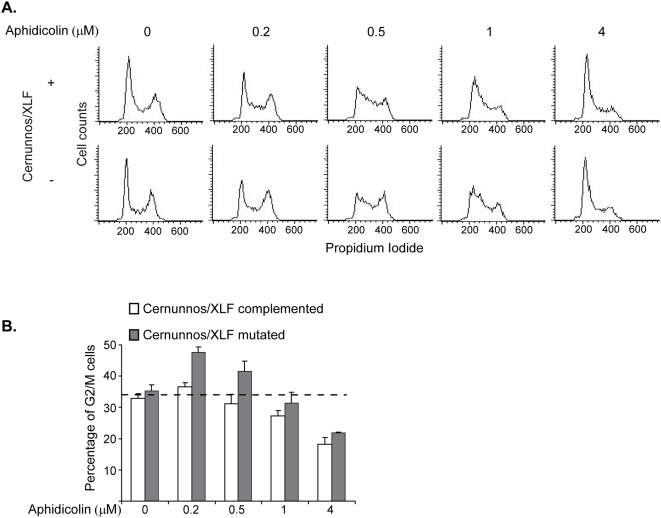
Cernunnos/XLF mutated cells exhibit Increased accumulation of cells in G2/M following treatment with low aphidicolin concentrations.A. Cernunnos/XLF mutated and complemented cells were treated with the indicated aphidicolin concentrations for 24 hours, fixed, stained with propidium iodide and analyzed by FACS for DNA content. B. Quantification of the percentage of cells in G2/M following aphidicolin treatment. Bars represent mean and standard error of three independent experiments. The dashed line represents the approximate percentage of cells in G2/M in untreated cells.